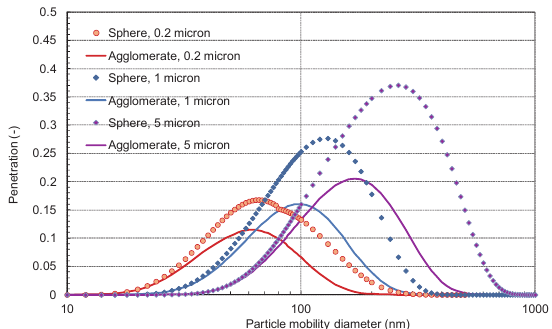
Fig. 10 Penetration values for spherical and agglomer- ated nanoparticles from model calculations for fiber sizes of 0.2, 1, and 5